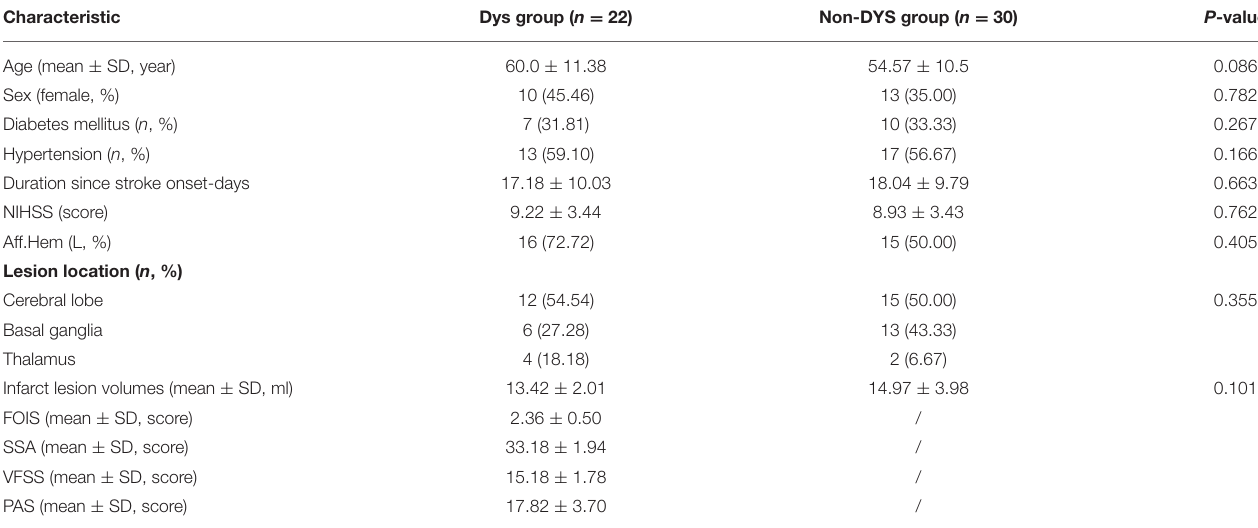
TABLE 1 | Clinical characteristics of the groups.